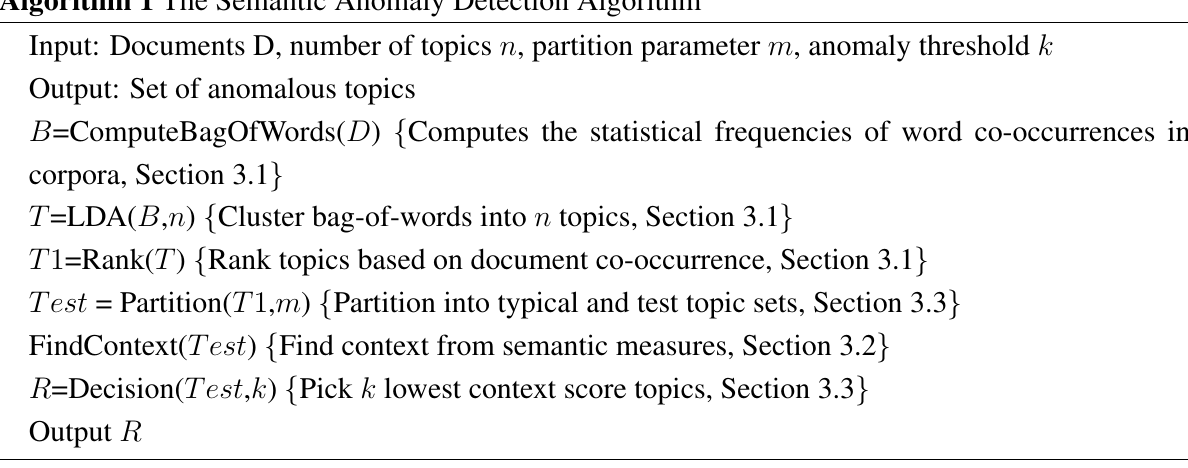
Algorithm 1 The Semantic Anomaly Detection Algorithm